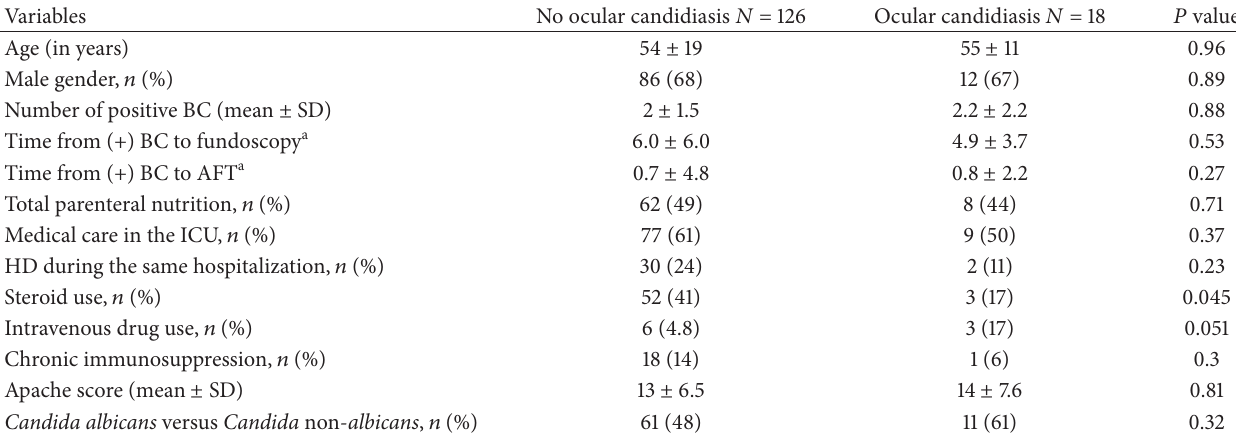
Table 2: Bivariate analysis of factors associated with ocular candidiasis.